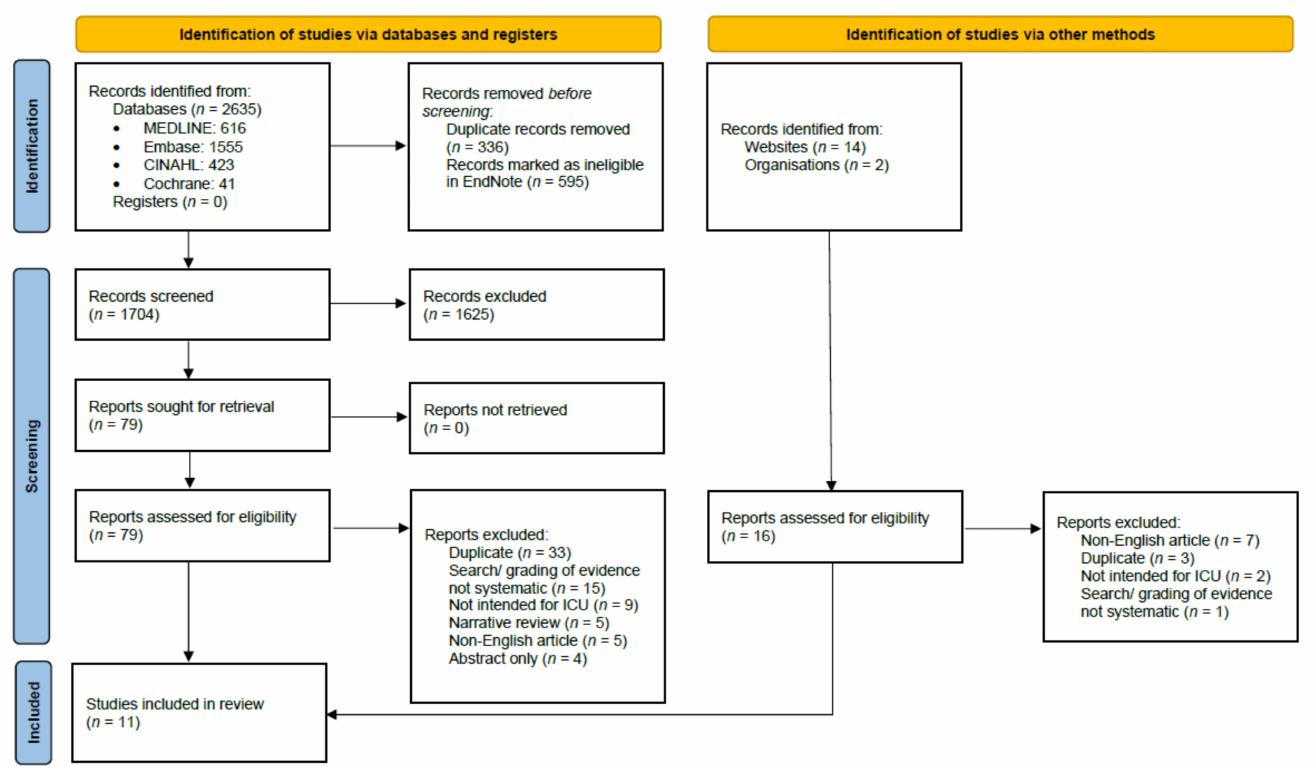
Figure 1. PRISMA flow diagram describing the selection and exclusion of studies.